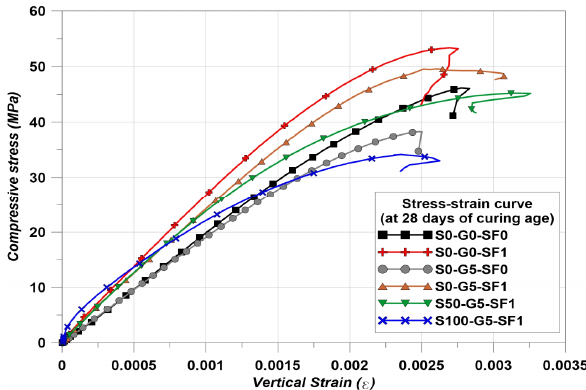
Figure 9. Compressive stress–strain curves.